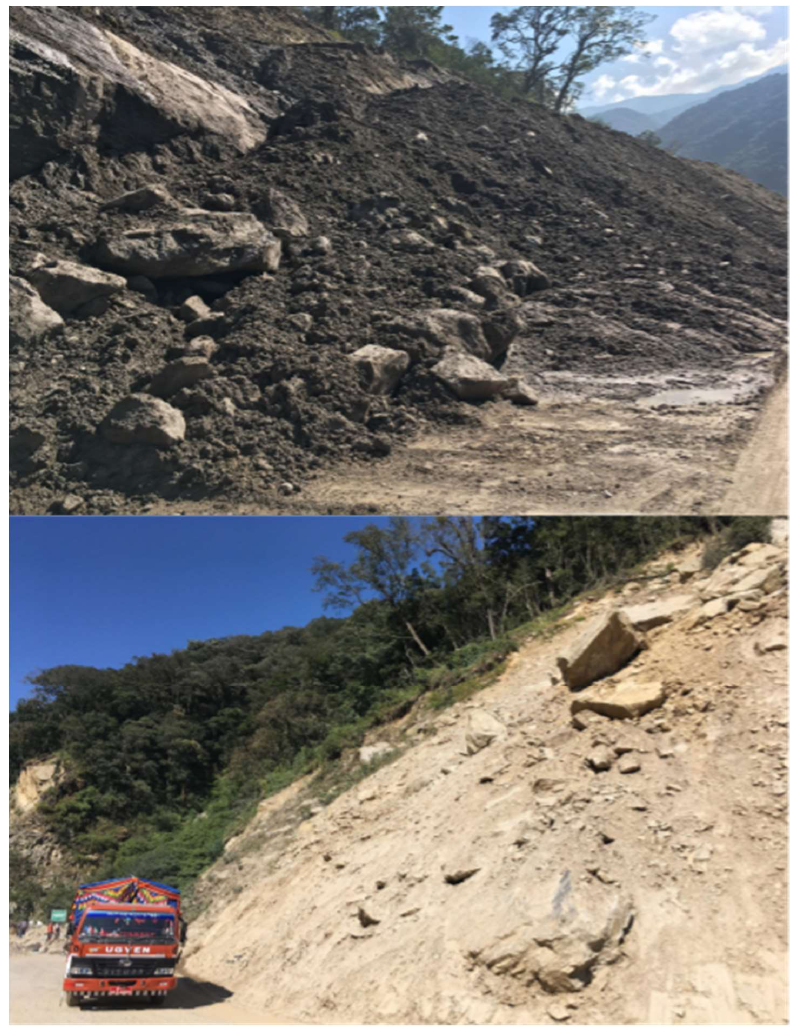
Figure 2. Landslide damage along Phuentsholing-Thimphu Highway (after 2017 monsoon).